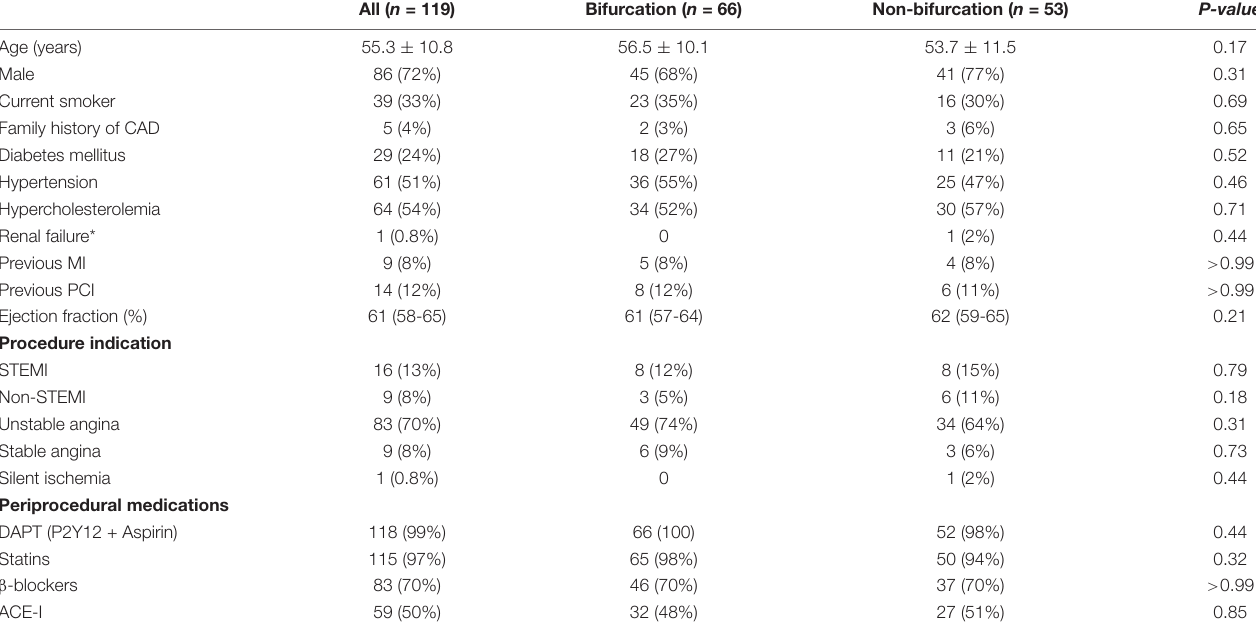
TABLE 1 | Baseline patient characteristics.